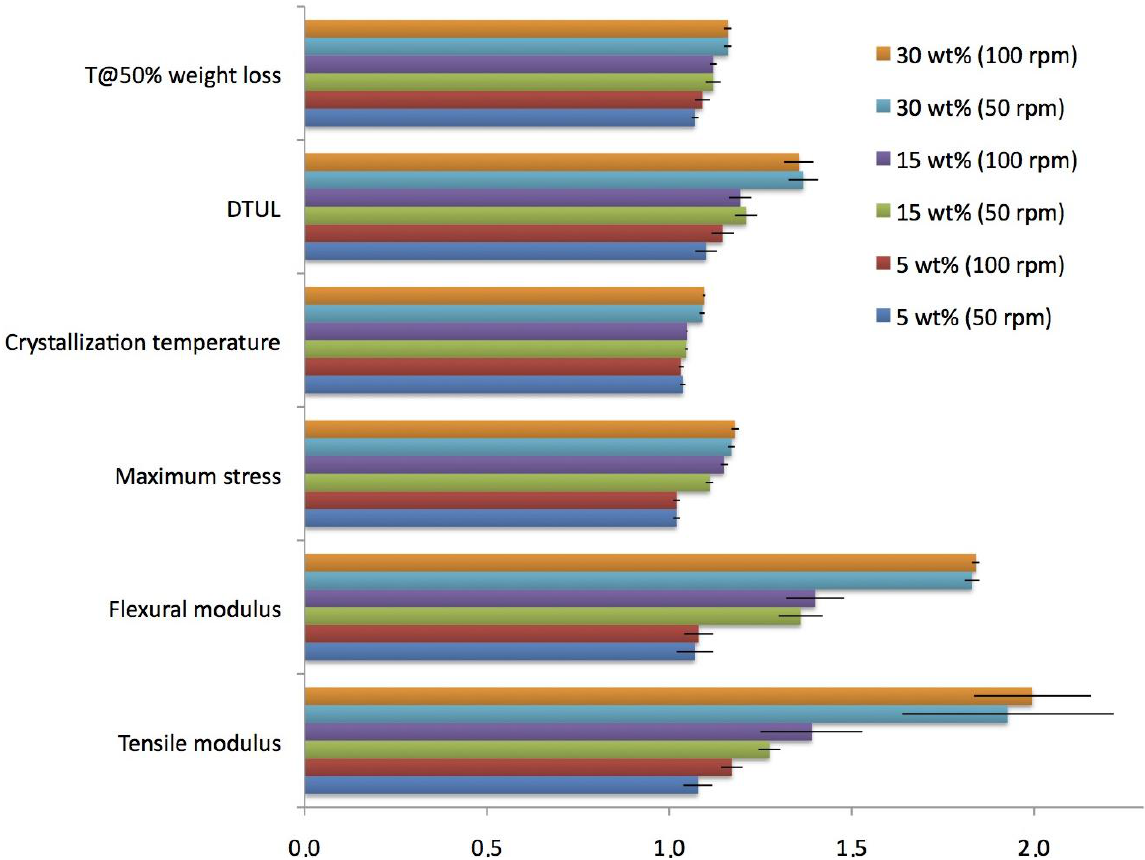
Figure 5. Parameters reported in Table 1 for PP-CR samples. The values are normalized with respect to the pristine